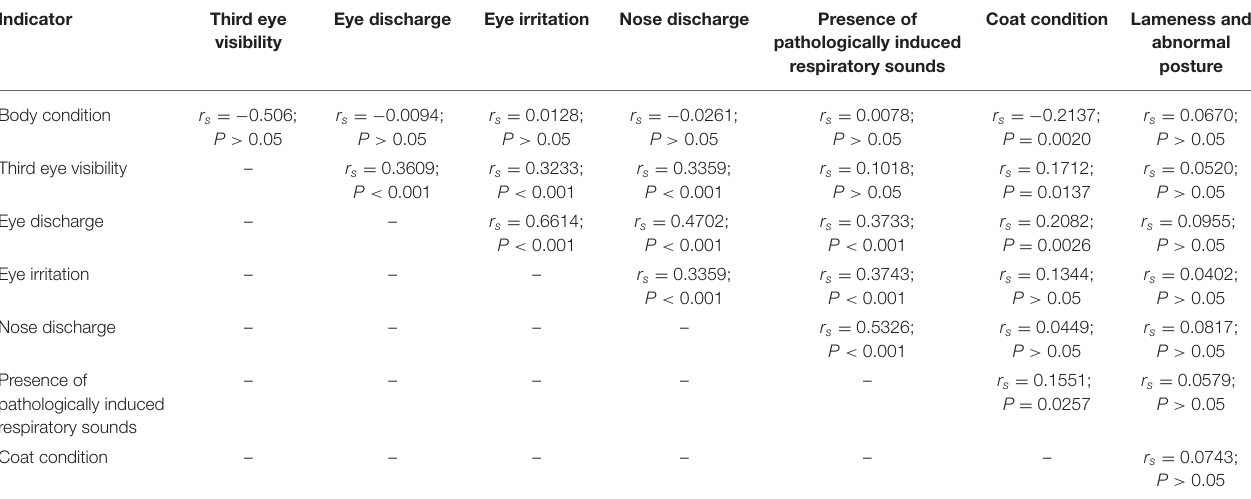
TABLE 6 | Correlations between mean scores of the individual indicators (Spearman’s rank correlation coefficient and P -values). Indicator Third eye Eye discharge Eye irritation Nose discharge Presence of visibility